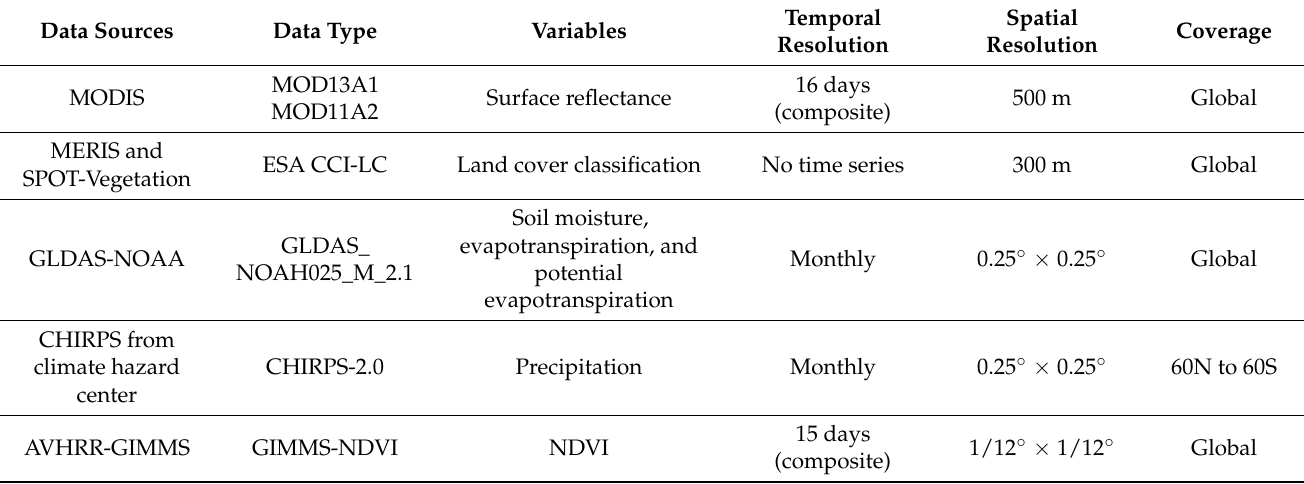
Table 1. The detailed specification of remote sensing data sets used in this study.